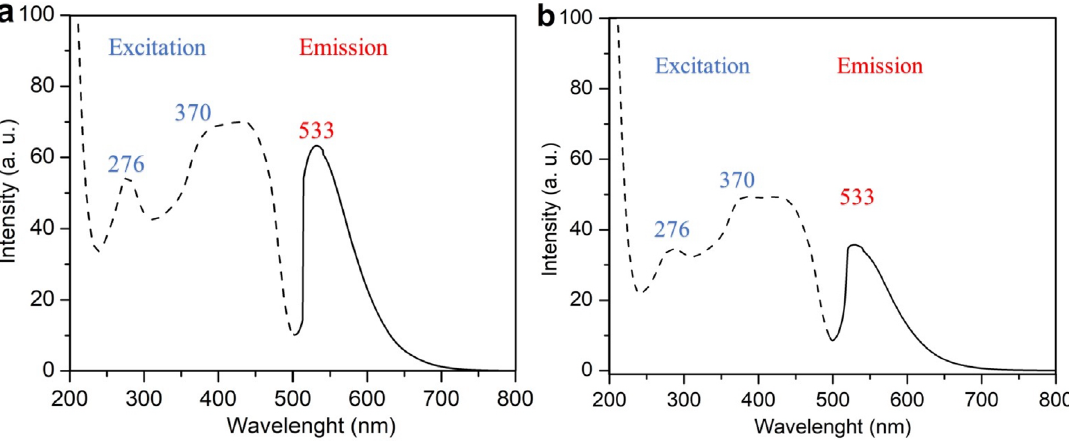
Figure 2: Excitation (dash line) and emission (straight line) spectrum of (a) ligand NH and (b) hybrid material SBA-15/APTES-NH